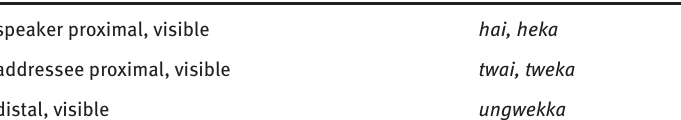
Table 1: Locative adverbial demonstratives (visible) speaker proximal, visible